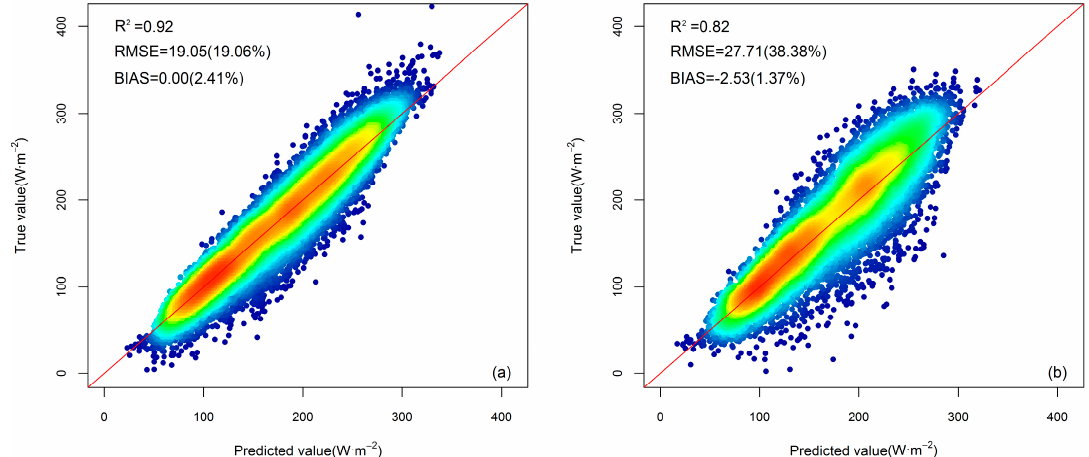
Figure 5. ( a ) Evaluation results of the training set’s daily estimated DSR based on the GBRT-based clear sky model against ground measurements in 2001 and 2002. ( b ) Evaluation results of the validation set’s daily estimated DSR based on the GBRT-based clear sky model against ground measurements in 2003. The number in the parentheses is the percent bias or root mean square error (RMSE) value.